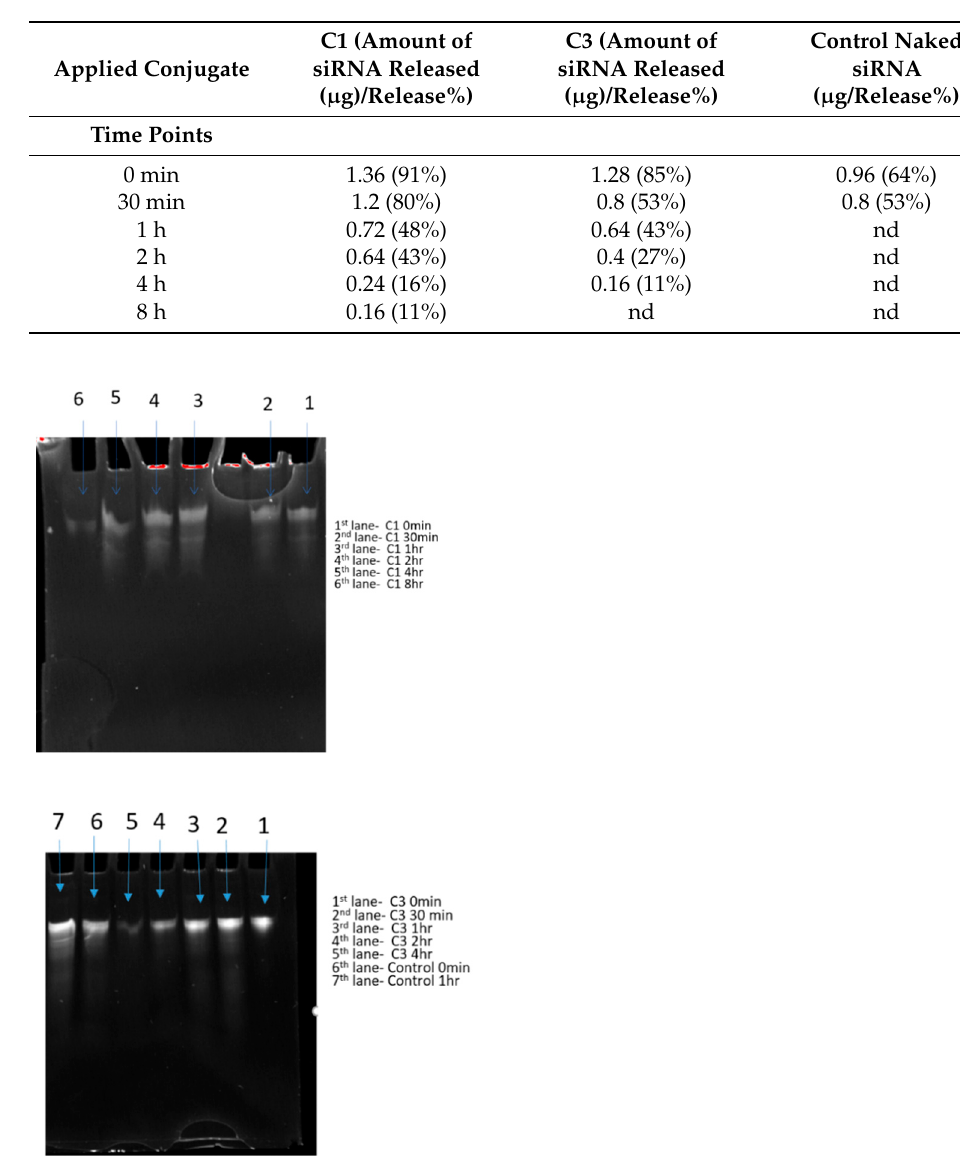
Table 3. Amount of intact siRNA in nanoparticles C1, C3 and control at different time points. nd = not detected.